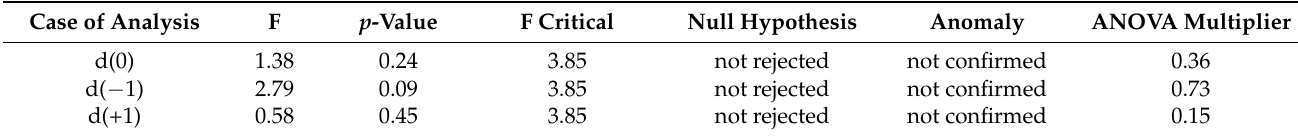
Table A2. ANOVA test of the expiration day price effects.